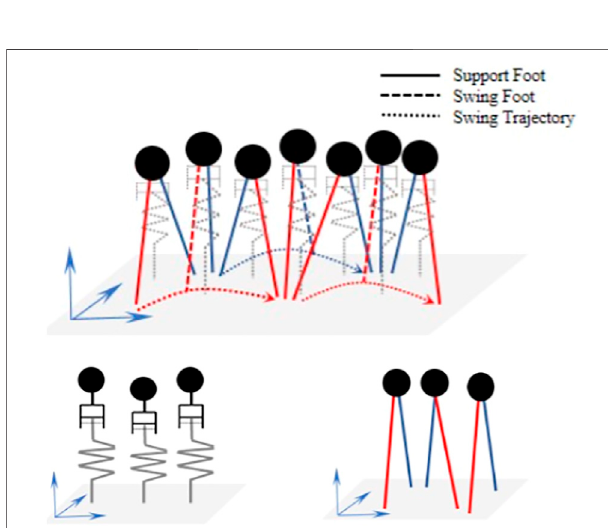
Frontiers in Robotics and AI |